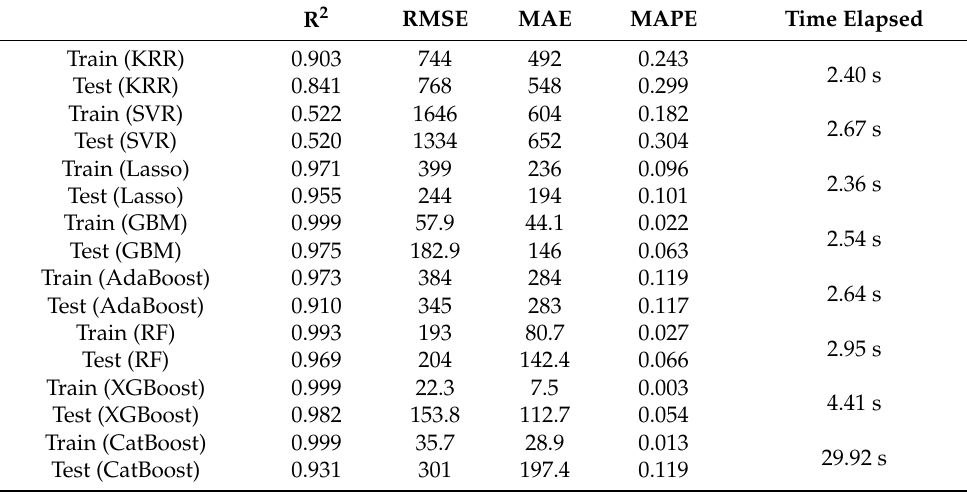
Table 1. Performance comparison of different machine learning